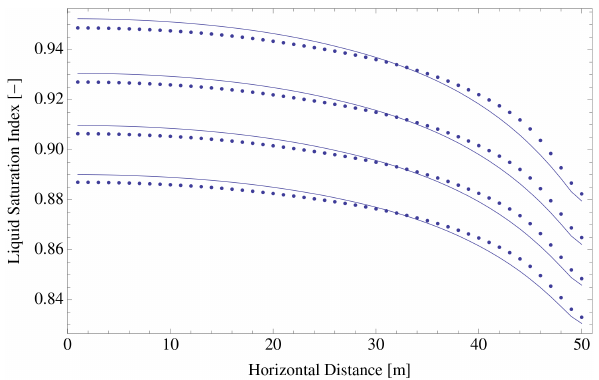
Figure 4. Comparison of current approach (solid) with two com- ponent air–water approach (circles) based on Painter (2011). The following properties were used: permeability = 3.2 × 10 − 12 m 2 , porosity = 0.53, thermal conductivity (dry) = 0.067Wm − 1 K − 1 , thermal conductivity (wet) = 1.23Wm − 1 K − 1 , thermal conductiv- ity (frozen) = 2.08Wm − 1 K − 1 , soil density = 2500kgm − 3 , spe- cific heat = 735Jkg − 1 K − 1 , van Genuchten α = 7.1 × 10 − 5 Pa − 1 and van Genuchten λ = 0.22.